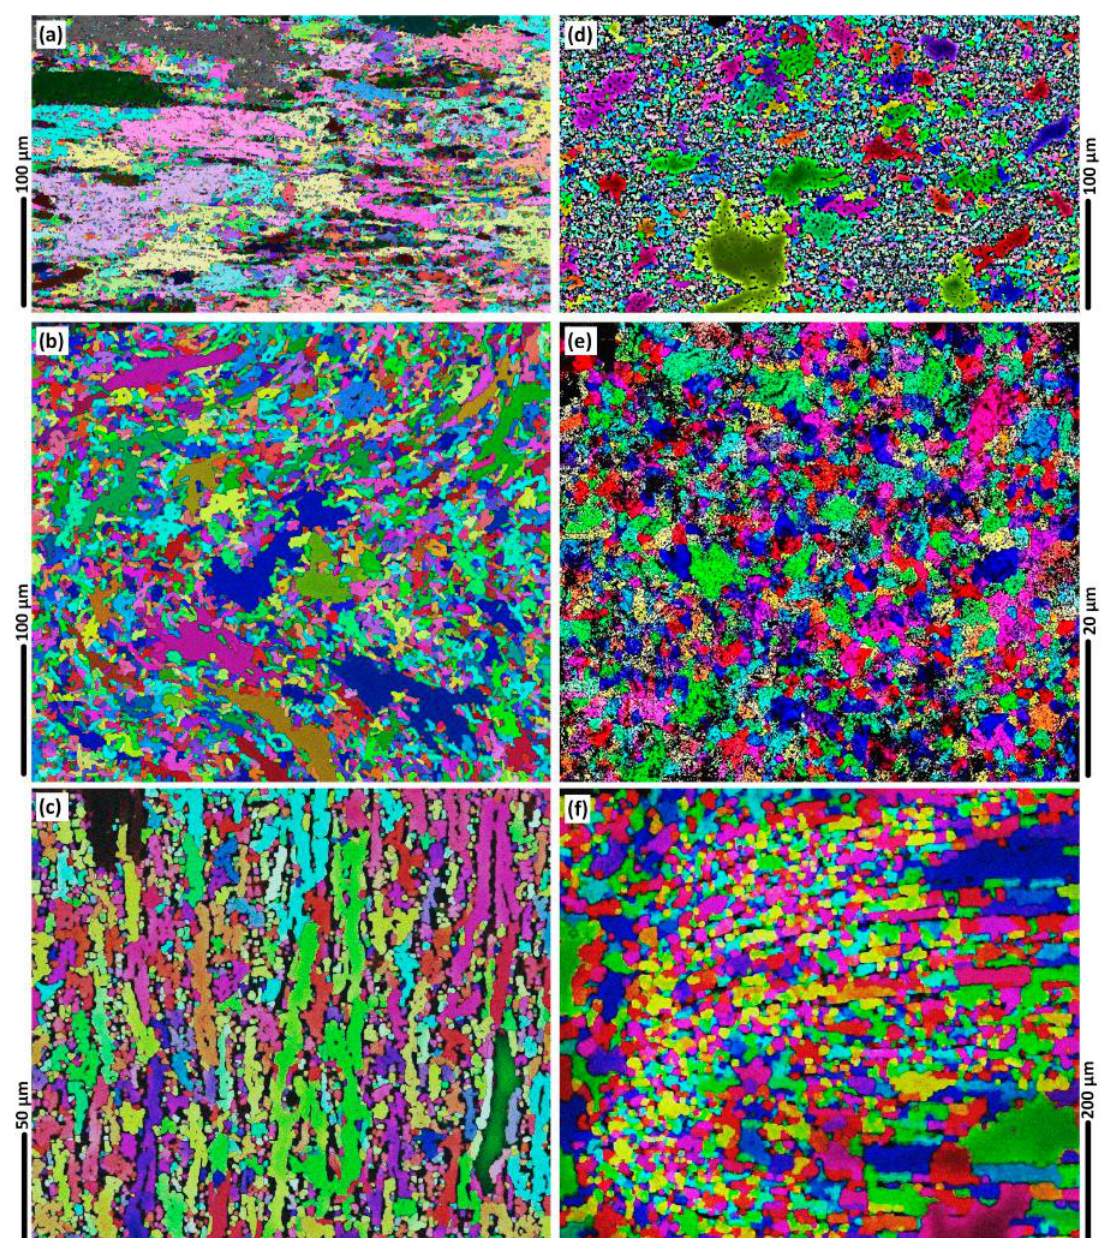
Figure 12. The Euler map micropatterns of the presence of HAGBs with post processing using a 15° angle, for different regions of the weld; BM ( a ); AS Hourglass border ( b ); Flow-arms ( c ); Sub-shoulder region ( d ); Mid-SZ ( e ); RS Hourglass border ( f ).